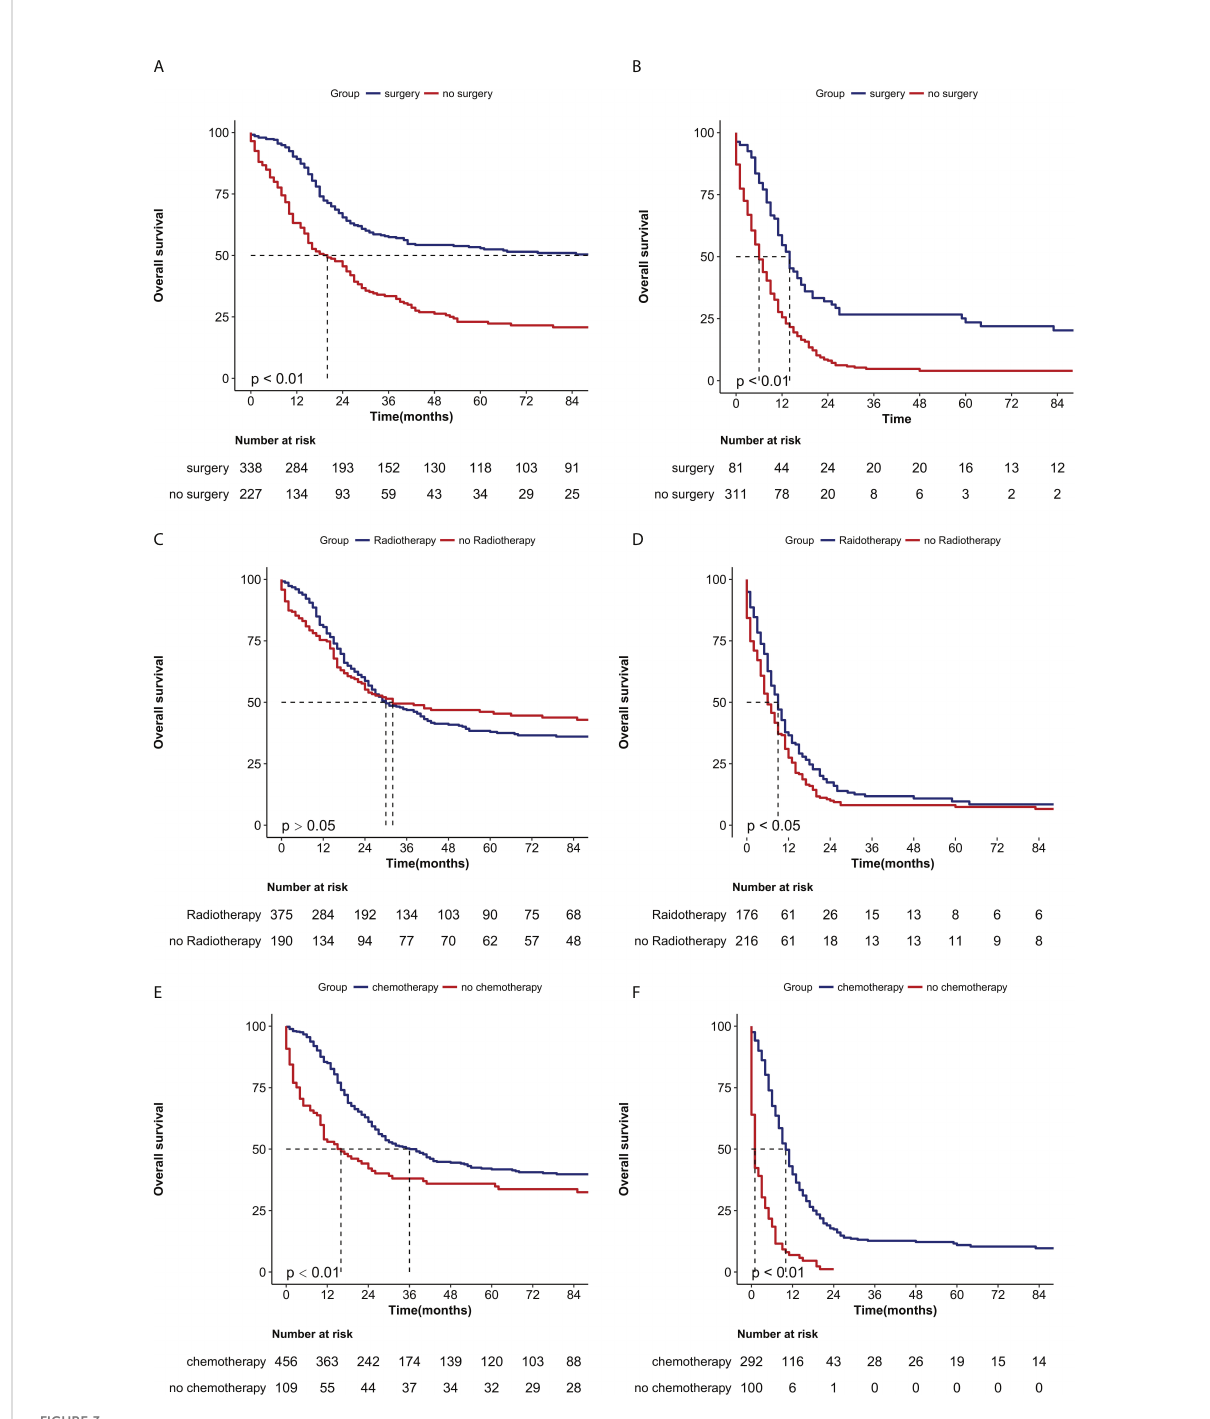
FIGURE 3 Kaplan-Meier curves of the overall survival in NECC with no metastasis or metastasis when strati fi ed by treatment. (A) Surgery in no metastasis patients ( P < 0.0001); (B) Surgery in metastasis patients ( P < 0.0001) (C) Radiotherapy in no metastasis patients ( P > 0.05), (D) Radiotherapy in metastasis patients ( P < 0.05), (E) Chemotherapy in no metastasis patients ( P < 0.001) (F) Chemotherapy in metastasis patients ( P <